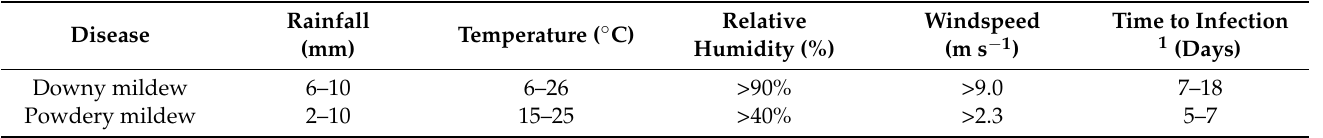
Table 1. A summary of the main factors that favor growth and dispersion of P. viticola and U. necator diseases on grapevine and range of time to